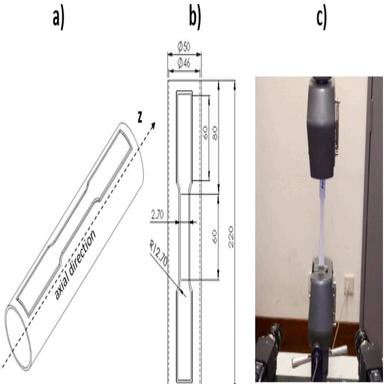
(a) Shape of the uniaxial tensile specimen extracted from the tube; (b) Dimensions of the UTT specimen; (c) UTT experiment test using DIC for strain measurement.